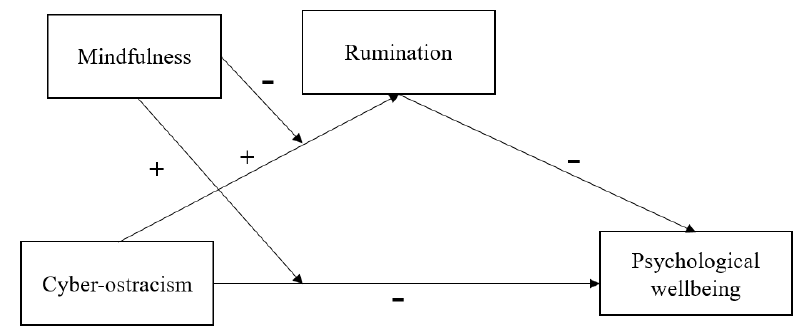
Figure 1. The proposed moderated mediation model.